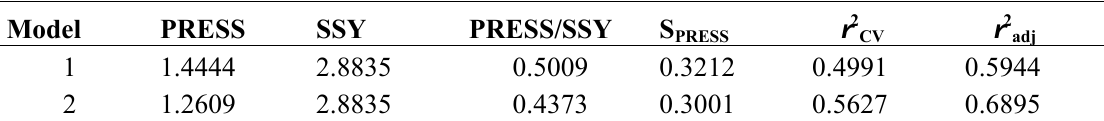
Table 5. Cross-validation